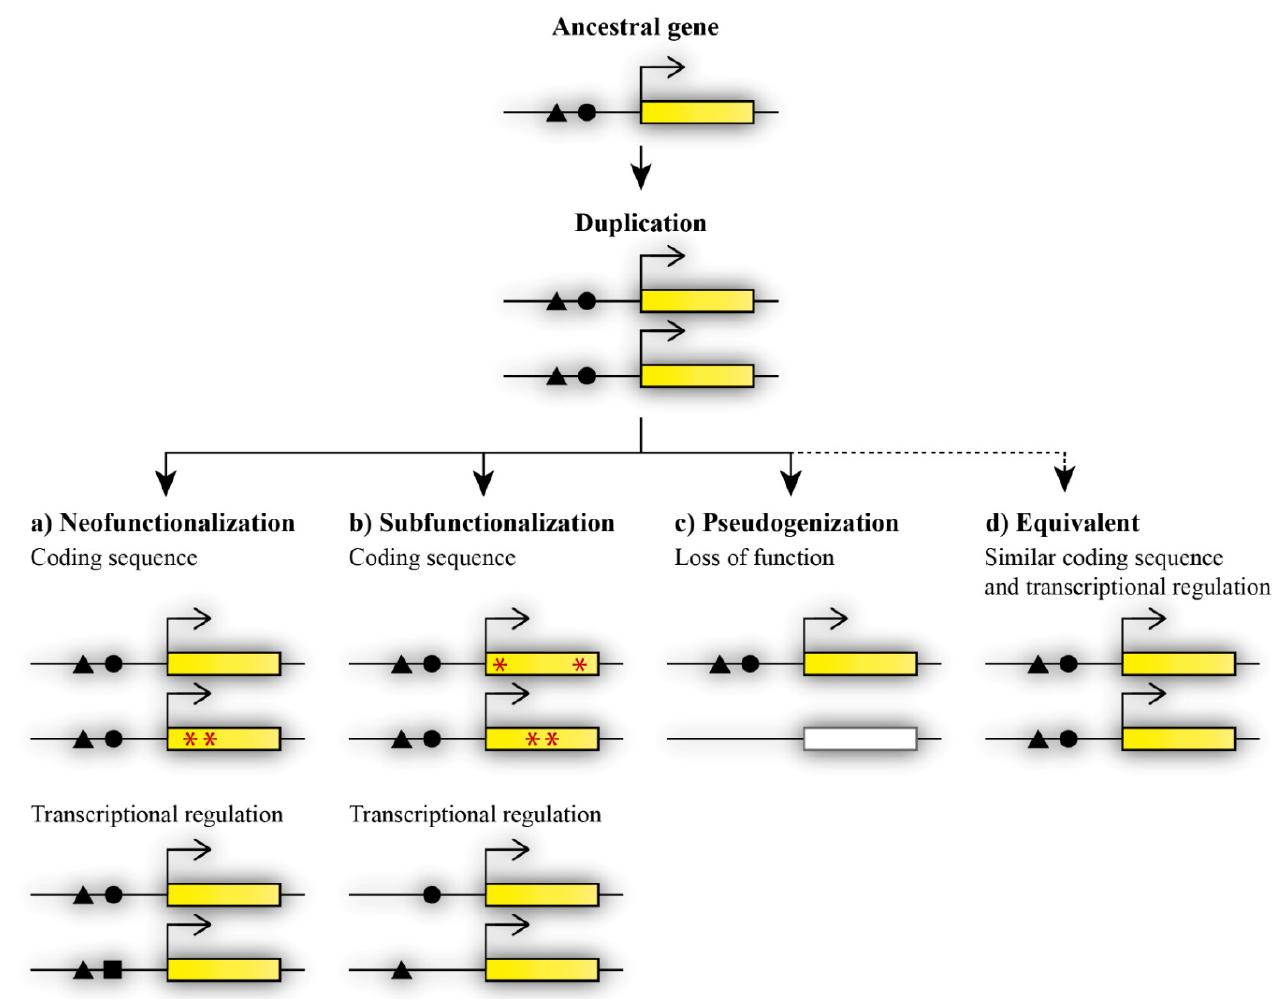
Figure 1. Possible fates of paralogous genes after duplication. Duplicated genes can acquire divergent functions via ( a ) neofunctionalization, in which one duplicate retains the ancestral gene function while the other duplicate acquires a novel function, and the acquisition of the novel function occurs through mutations in the gene coding sequence (indicated by red asterisks) or changes in transcriptional regulation (black square), or ( b ) subfunctionalization, in which mutations change the functions of both duplicates at the level of coding sequence (red asterisks) or transcriptional regulation (missing black triangle or circle), therefore causing the presence of both copies to be essential for the maintenance of the ancestral function. Other possible fates of duplicated genes are ( c ) loss of function during the pseudogenization process, or, less frequently occurring, ( d ) maintained equivalent functions.